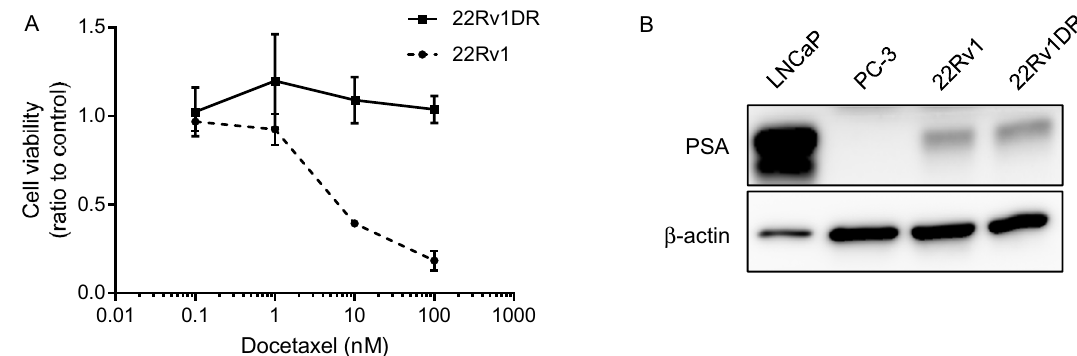
Figure 2. Characteristics of Docetaxel-resistant cell line, 22Rv1DR. ( A ) 22Rv1DR cells were treated with docetaxel at indicated concentrations. Seven days after treatment, cell viability was determined by WST-1 assay. Data shown are mean with SD (n = 5 in each group). ( B ) Cell lysates were harvested from LNCaP, PC-3, 22Rv1, 22Rv1DR cells and subjected to Western blot analysis for PSA and β-actin. The blots were cropped and full length blots are presented in Supplementary